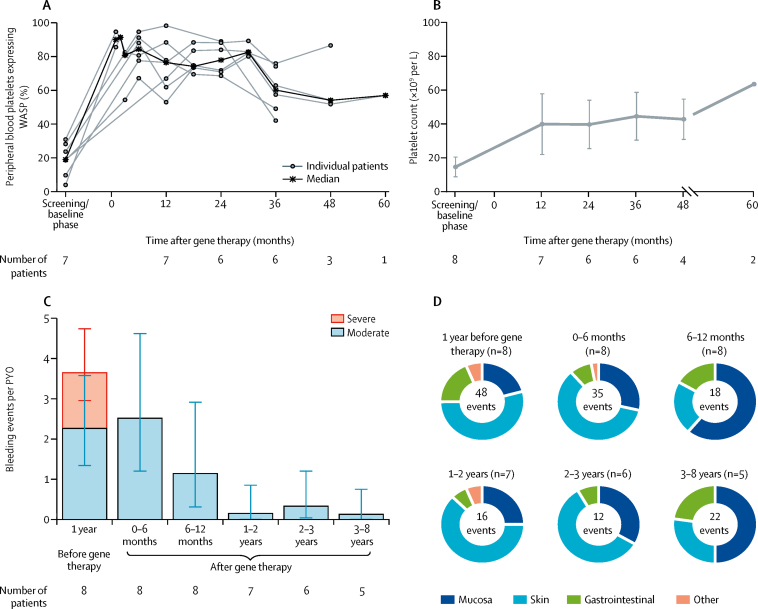
Platelets and bleeding eventsGene therapy was administered on day 1 (month 0). (A) Percentage of platelets expressing WASP, as measured by flow cytometry. (B) Mean (SD) platelet count (× 109 cells per L). SD is not plotted for follow-up at 60 months because data were available for only two patients. (C) Moderate or severe bleeding events (per PYO) for each observation period. Error bars represent the 95% CI. (D) Distribution of all bleeding events for each observation period, by body site. Total number of events for each observation period is shown in the centre of each chart. WASP=Wiskott-Aldrich syndrome protein. PYO=patient-year of observation.